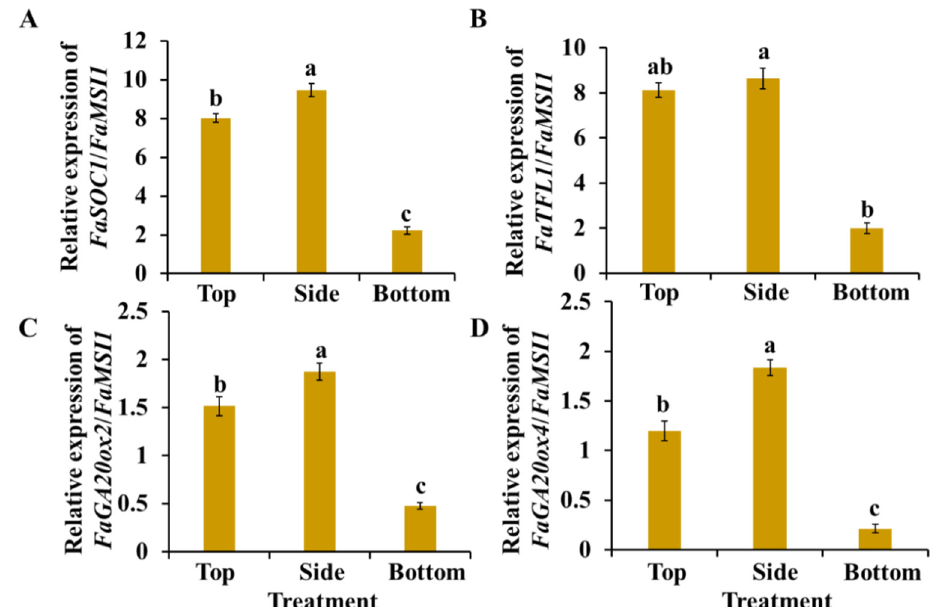
Figure 9. Changes in the gene expression levels in strawberry ‘Sulhyang’ plants as affected by the lighting direction after 45 days of cultivation. Flowering repression and runner formation promotion-related genes ( FaSOC1 and FaTFL1 ) ( A , B ), GA biosyntheses-related genes ( FaGA20ox2 and FaGA20ox4 ) ( C , D ). Verticsal bars indicate the means ± standard error ( n = 6). Different lowercase letters indicate significant separations within treatments by Duncan’s multiple range test at p ≤ 0.05.